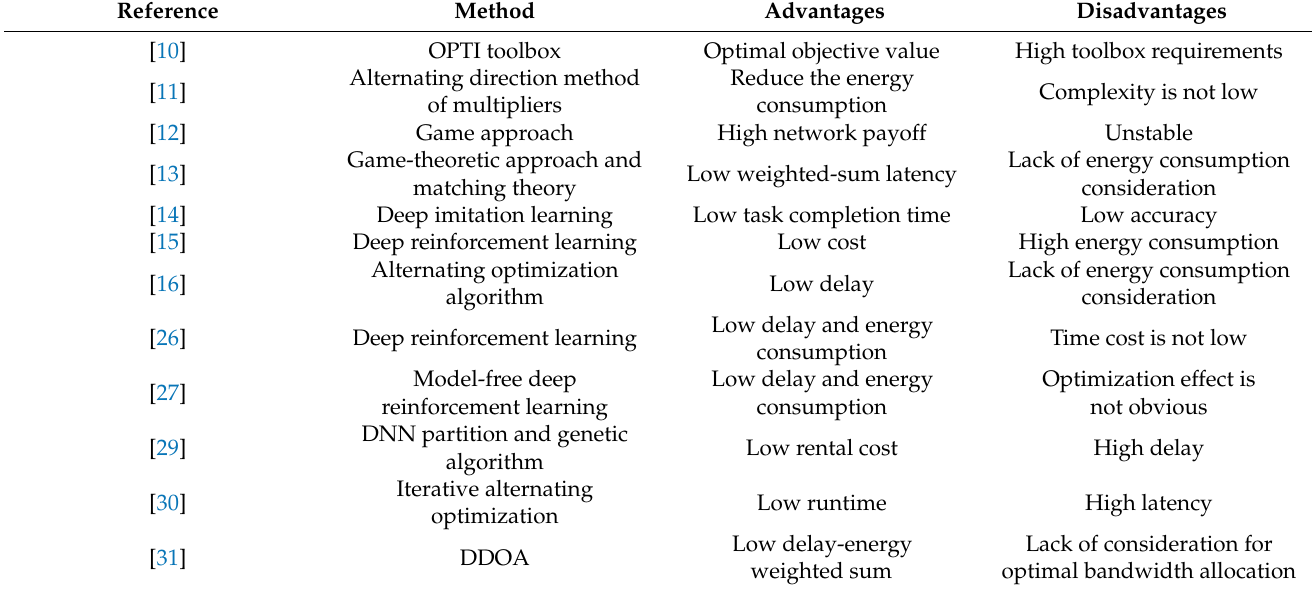
Table 1. Comparison of the related works.